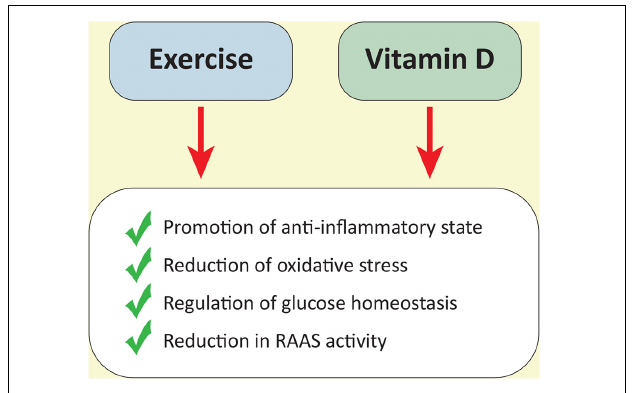
FIGURE 3 | A schematic representation of beneficial processes triggered by both exercise and the vitamin D